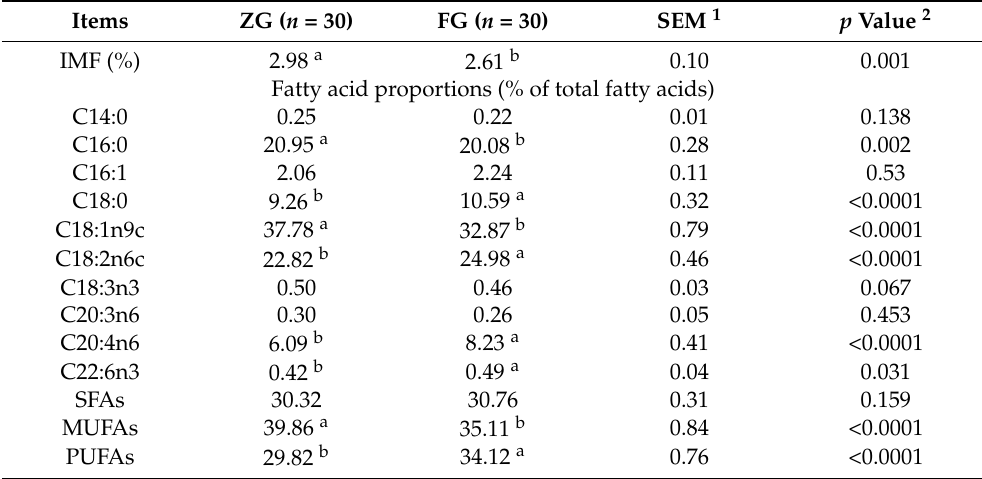
Table 3. Breast muscle proximate composition (IMF content and fatty acid proportion) in the ZG and